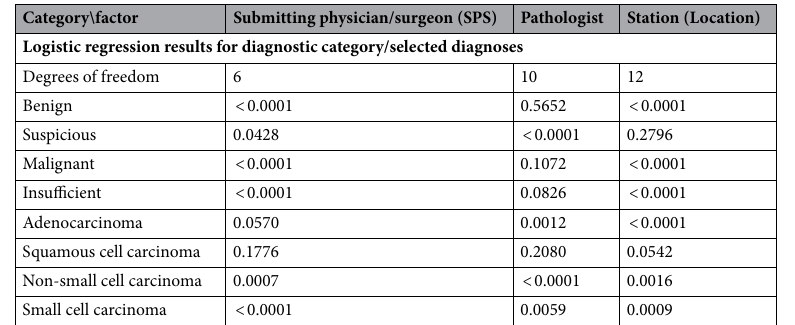
Table 3. Logistic regression results in cohort for mutually exclusive grouping and diagnosis (selected) with the predictors: SPS, Pathologist, and Station (Location).